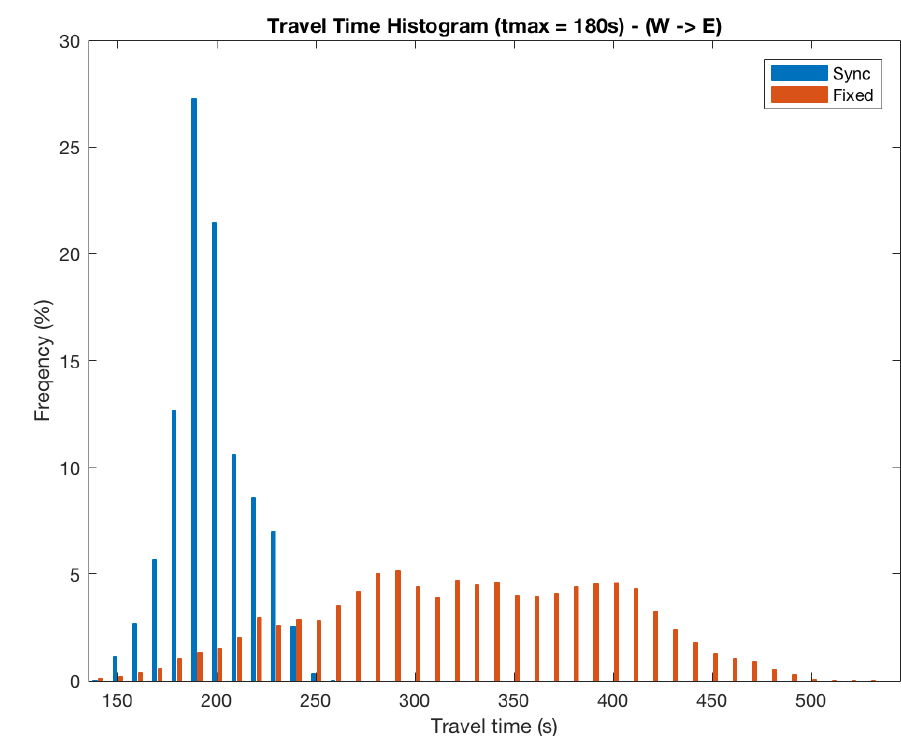
Figure 12. Travel time distribution: fixed time Traffic Light Control System (TLCS) vs. synchronized Adaptive Traffic Light Control System